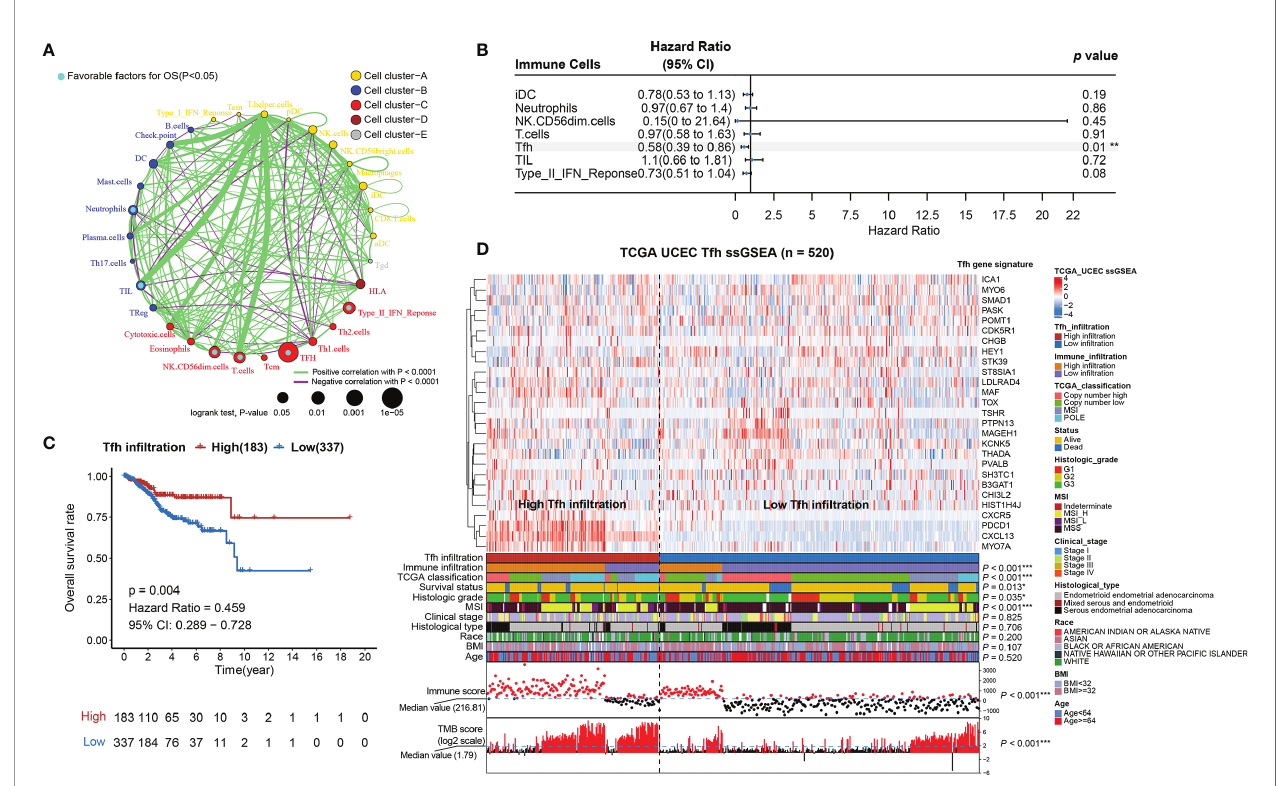
FIGURE 2 | Tfh is a signi fi cant favorable cell for OS in EC. (A) Cellular interaction circus plot of the immune cell types. The size of each circle indicates the survival impact of each immune cell type and is inversely proportional to the p -value when using the log-rank test formula. Cell clusters are represented in yellow, blue, red, brown, and gray for clusters A, B, C, D, and E, respectively. The line thickness represents the estimated value of the Spearman correlation coef fi cient for each cell type ( p < 0.0001). A positive and negative correlation is represented in green and purple, respectively. Favorable immune cells for overall survival are indicated in turquoise. (B) Forest plot of the multivariate analyses of seven signi fi cant immune cells with overall survival (** p < 0.01). (C) Kaplan – Meier curve of overall survival rates in EC patients with high-Tfh and low-Tfh signature ( p = 0.004). (D) Tfh gene signatures of 520 EC specimens, organized by Tfh in fi ltration levels. Unsupervised consensus clustering grouped gene sets into two major categories based on Tfh in fi ltrations. Clinicopathological characteristics of the 520 EC patients are shown in the annotation, and different colors represent the characteristics and subtypes. The statistical differences in variables between two clusters were compared using the Fisher ’ s exact test. * p < 0.05, ** p < 0.01, *** p <